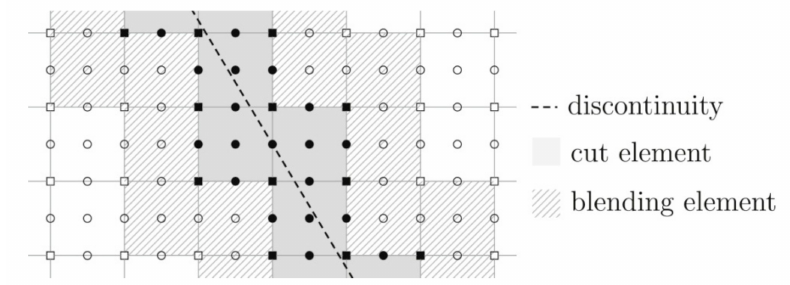
Figure 2. Planar crack, cut element, and blending